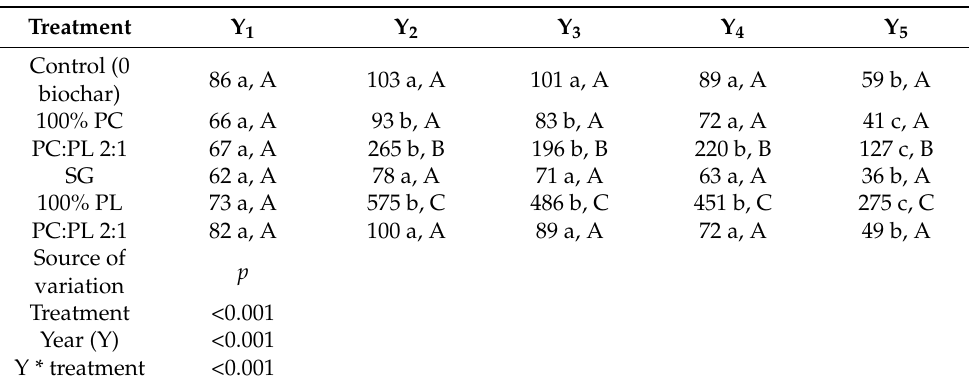
Table 4. Topsoil (0–15 cm deep) Mehlich 1 extractable soil phosphorus (P) concentrations in kg ha − 1 by treatment and year (means from n = 4; Y = year; PC = pine chip biochar; PL = poultry litter biochar; SG = switchgrass